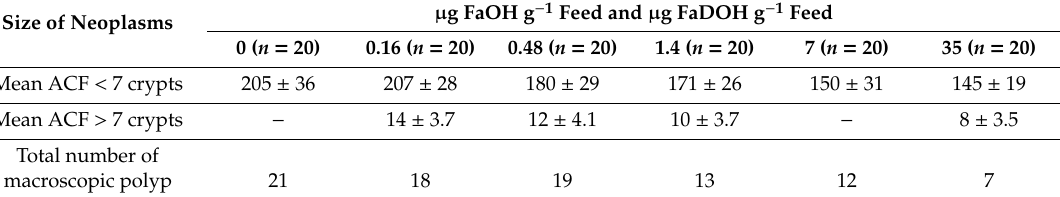
Table 1. The mean ± SD of small ACF ( < 7 crypts) and large ACF ( > 7 crypts) and the total number of macroscopic polyp neoplasms (benign tumors > 1 mm) in 6 groups of 20 azoxymethane (AOM)-induced rats receiving a standard rat diet (SRD) or a SRD supplemented with different doses of FaOH and FaDOH. − Indicate no data are available.